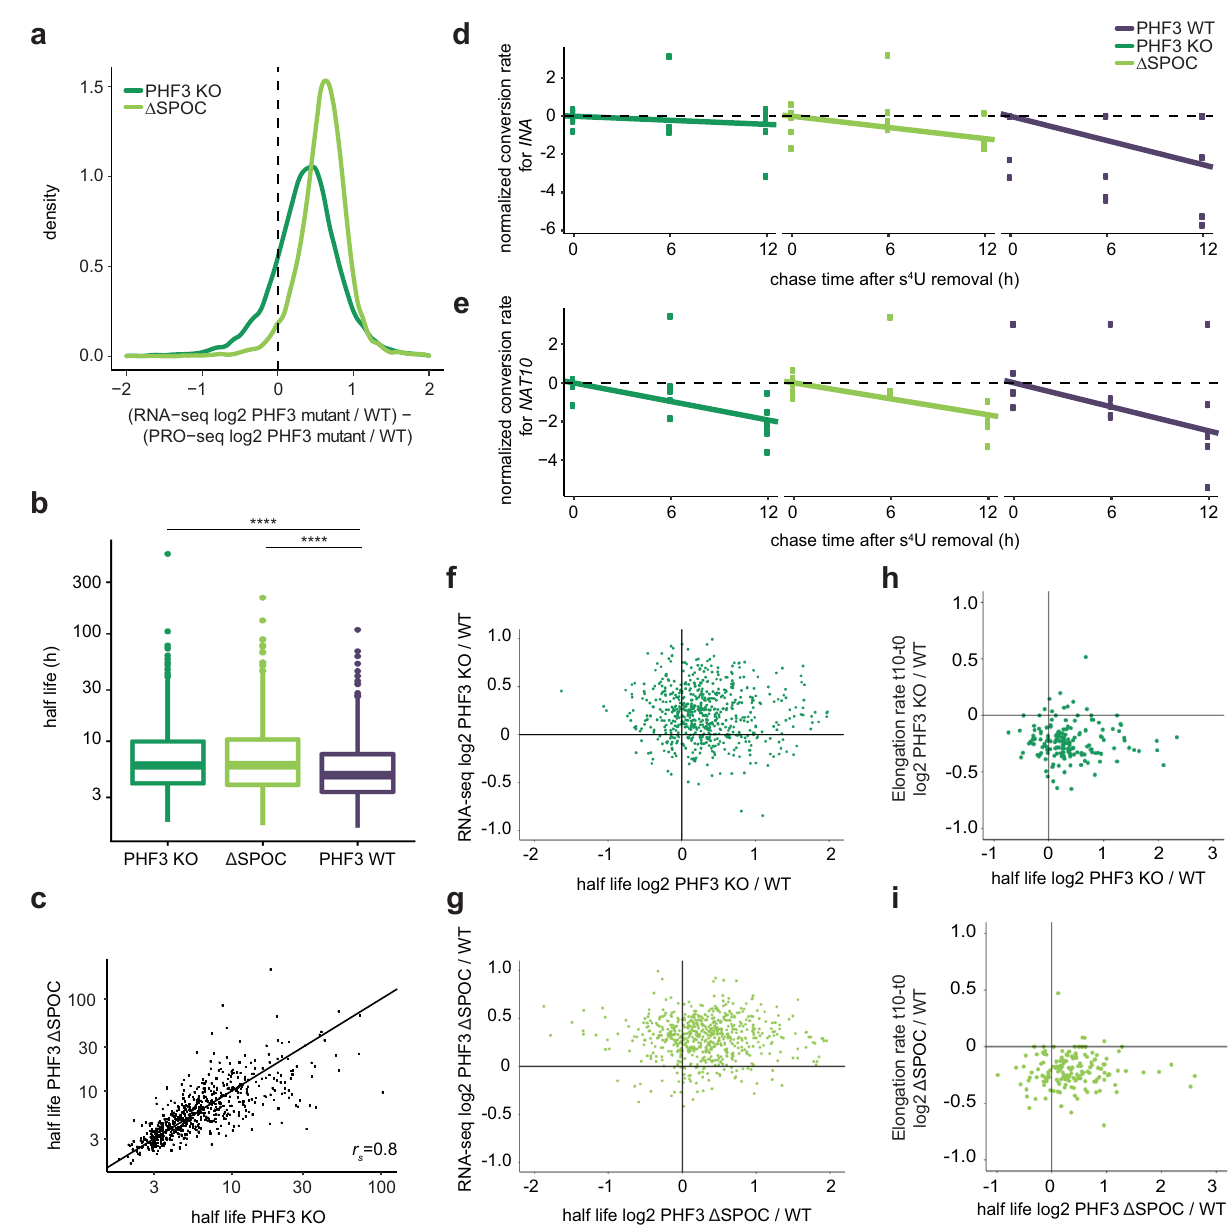
Fig. 6 PHF3 negatively regulates mRNA stability via the SPOC domain. a Density distribution of the differences in log2 fold changes PHF3 KO/WT or PHF3 Δ SPOC/WT between RNA-seq and PRO-seq data. b Comparison of mRNA half-lives for 757 genes calculated from T-C conversion rates as determined by SLAM-seq in PHF3 WT, KO, and Δ SPOC cells ( n = 6). Median Spearman correlation coef fi cient of conversion rates for replicate samples belonging to the same group (same genotype and timepoint) was 0.75 (see Supplementary Fig. 12c). The difference between the distributions is statistically signi fi cant based on the one-sided Wilcoxon test [ P (KO – WT) = 1.34 × 10 − 11 , P ( Δ SPOC – WT) = 2.28 × 10 − 11 ]. Statistics are indicated in detail in Supplementary Data 7. c , Scatter plot showing correlation between half-lives in PHF3 Δ SPOC and PHF3 KO. Spearman ’ s correlation coef fi cient is indicated. d , e Conversion rates determined from targeted SLAM-seq analysis of d , INA mRNA and e , NAT10 mRNA as a control labeled with s 4 U for 12 h followed by pulse chase for 6 h and 12 h. Robust linear models were fi t on the linearized form of the exponential decay equation. Y-axis shows the log2 conversion rate, shifted by the median conversion rate at t = 0 h. For INA : t 1/2 = 3.3 h (WT), 7.1 h ( Δ SPOC), 19.5 h (PHF3 KO). For NAT10 : t 1/2 = 3.3 h (WT), 4.3 h ( Δ SPOC), 5.0 h (PHF3 KO). f , g Relationship between RNA-seq fold change and half-life fold change for f , PHF3 KO vs WT or g , PHF3 Δ SPOC vs WT. The majority of differentially regulated genes cluster in the top right quadrant that corresponds to mRNAs with increased steady-state levels and half-lives. h , i Relationship between t10 elongation rate (10 min after DRB washout) fold change and half-life fold change for h , PHF3 KO vs WT or i , PHF3 Δ SPOC vs